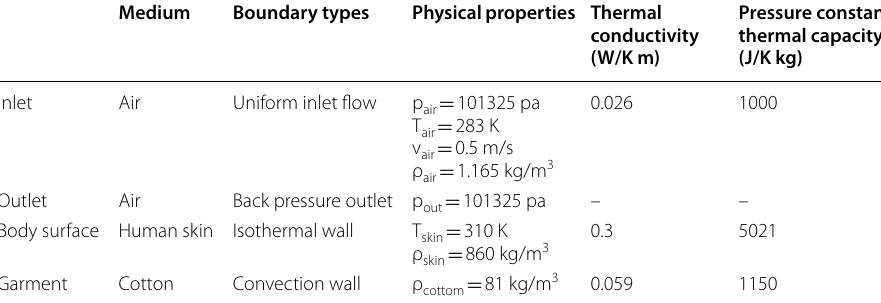
Table 1 Physical properties and boundary